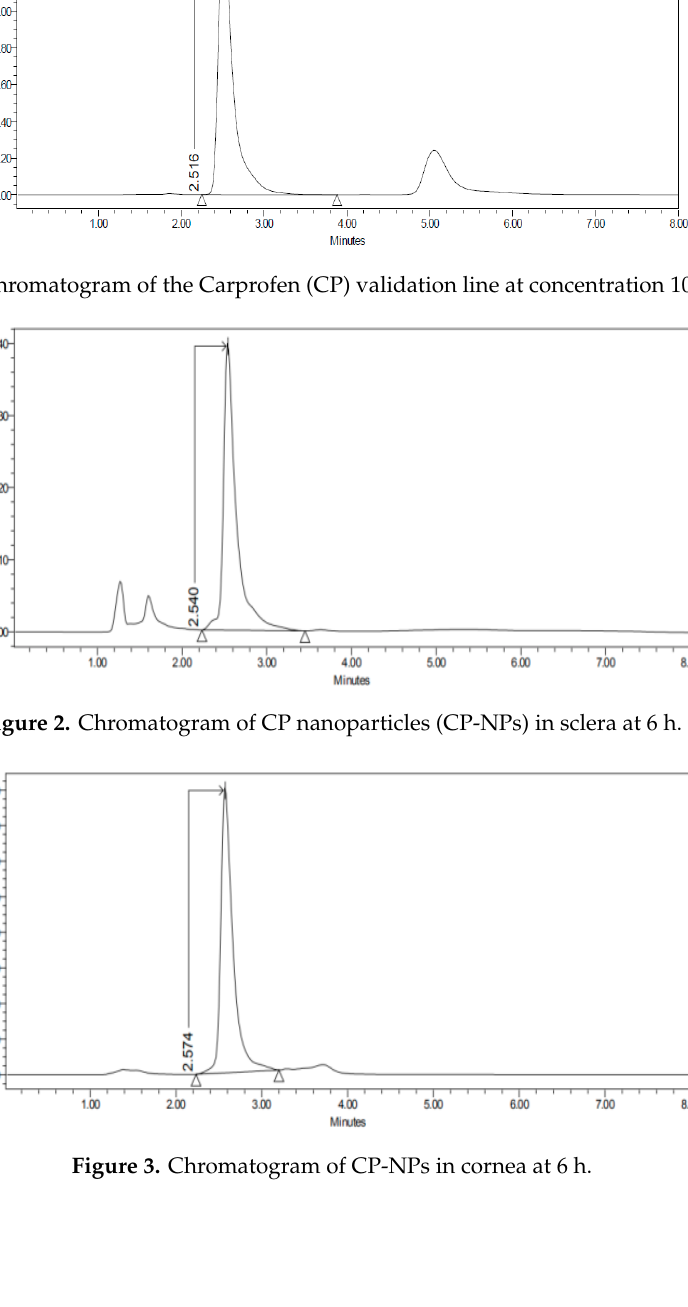
Figure 5. Chromatogram of CP-NPs in buccal mucous at 6 h.